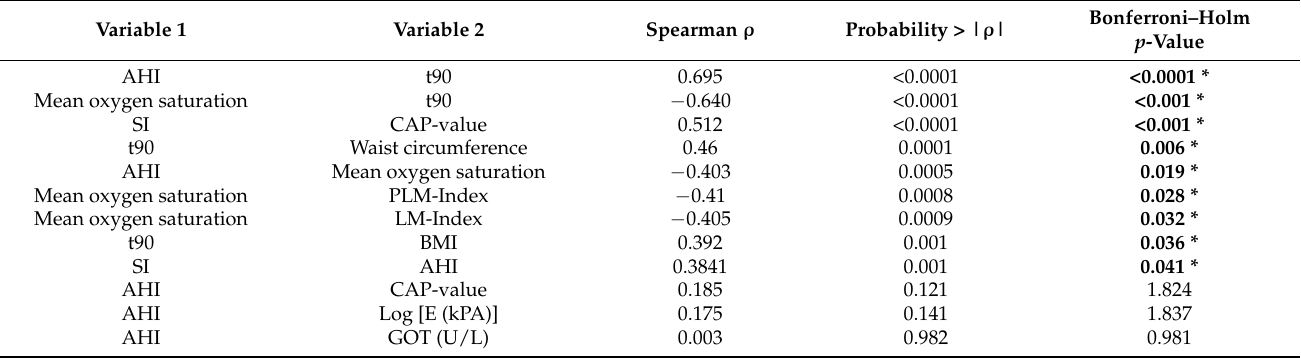
Table 1. Demographic data and collected parameters.